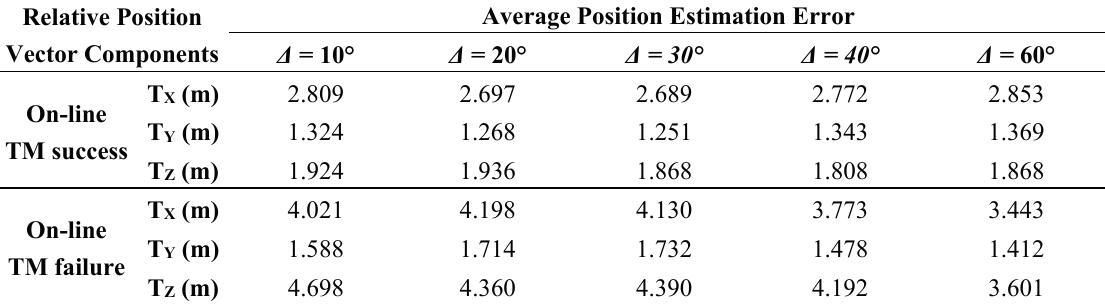
Table 3. On-line TM average estimation error in the relative position vector components for the considered two-orbit sequence of poses.